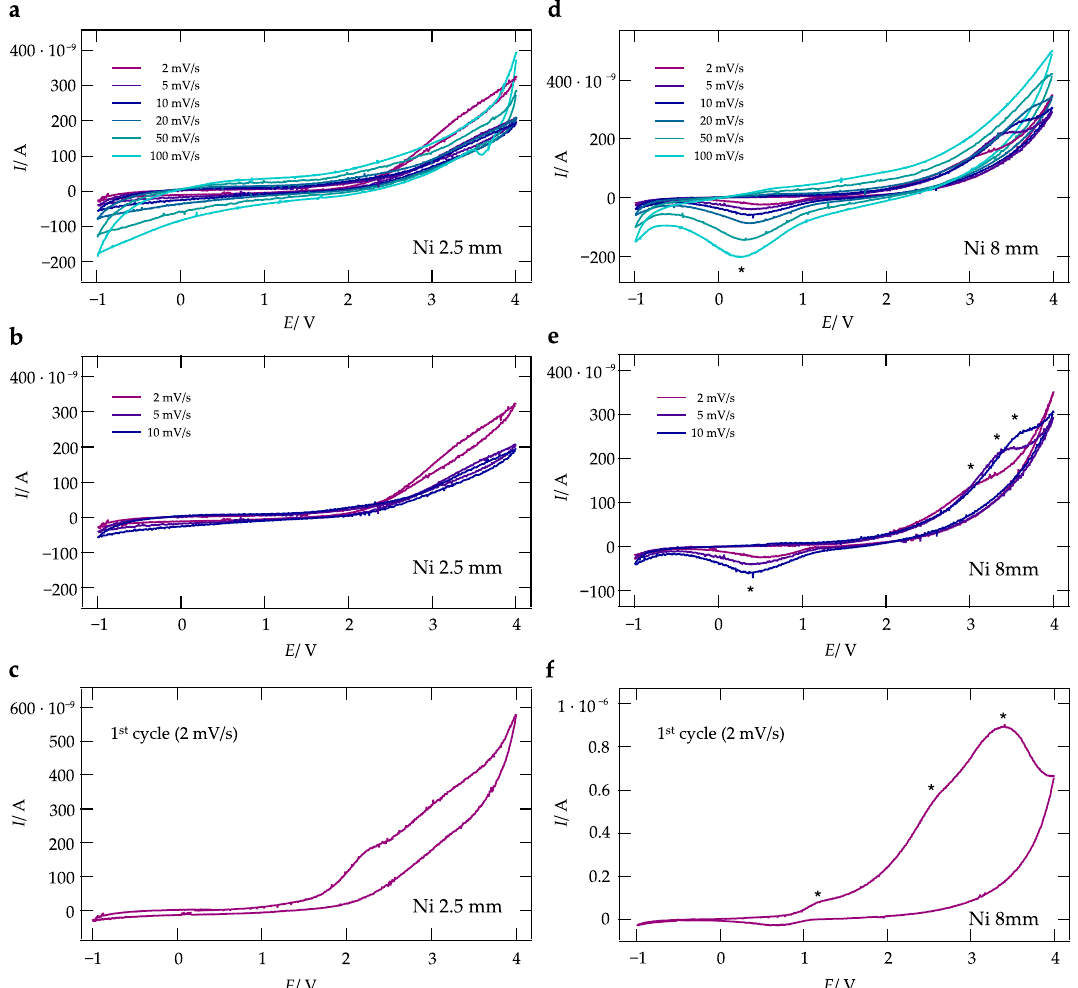
Figure 6. CVs of symmetrical cells with La 0.9 Ba 0.1 F 2.9 as electrolyte and Ni as electrode material. CVs were recorded at a temperature of 200 ◦ C; scan rates ranged from 2 mV/s to to 0.1 V/s. The diameter of the working electrodes was either 2.5 mm ( a – c ) or 8 mm ( d – f ).